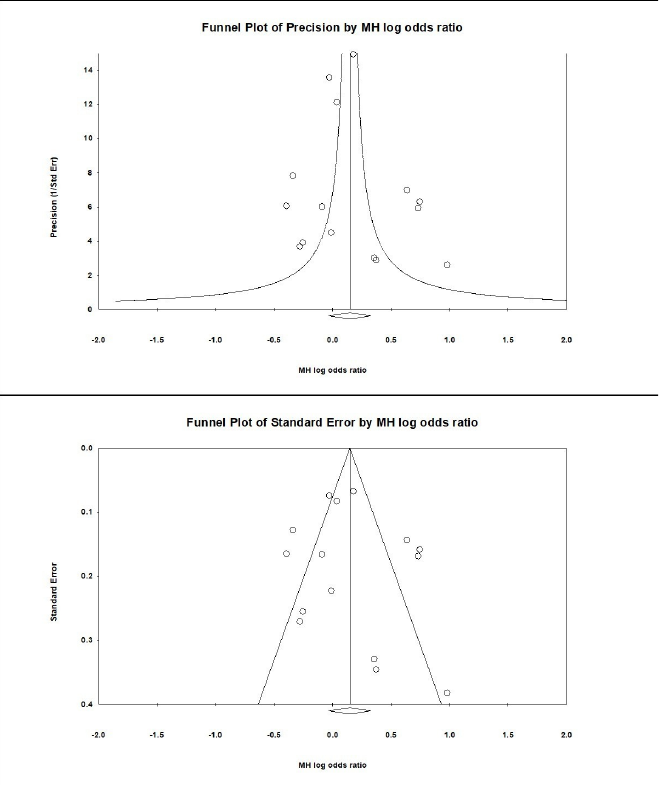
Figure 5. Funnel plots of precision and standard error demonstrating publication